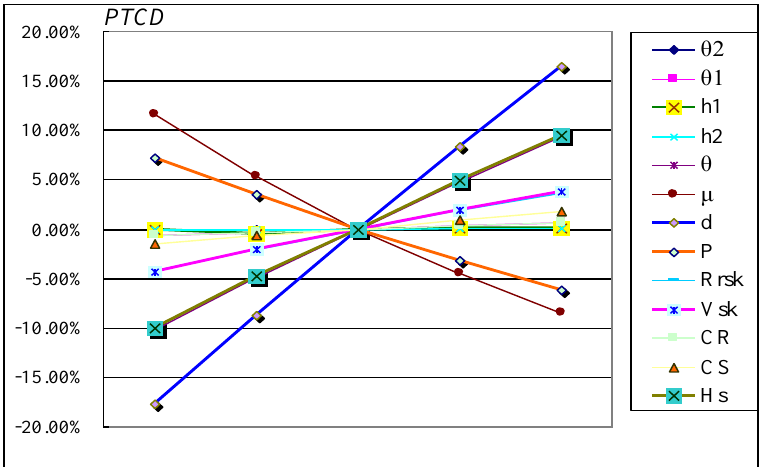
Figure 6. PTCD vs. change rate for economic production model with facility unreliability.